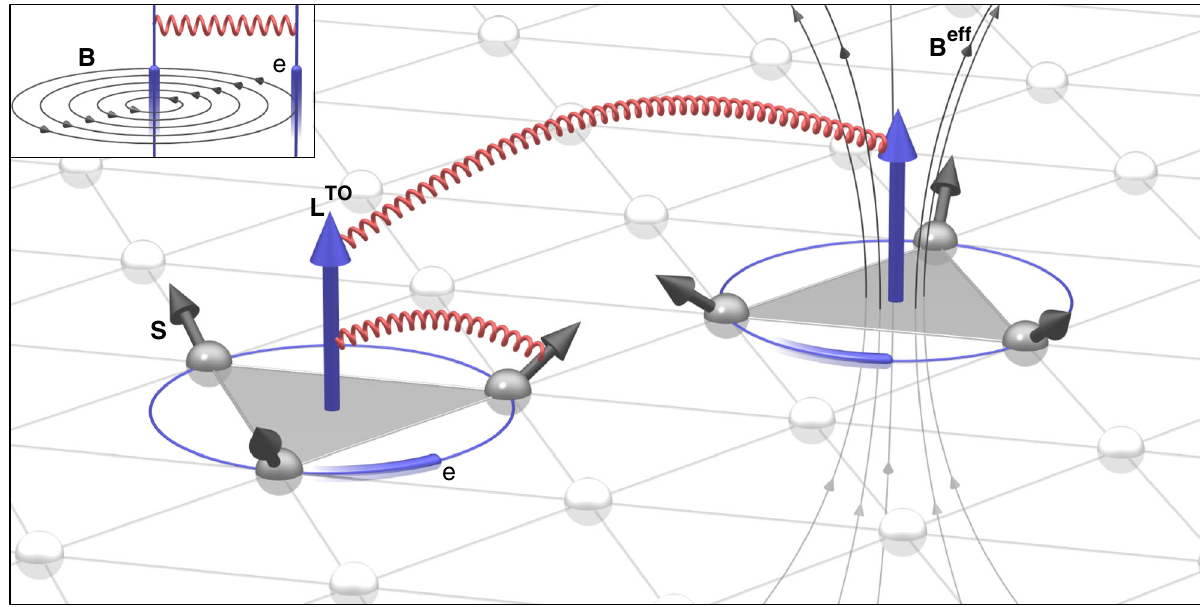
Fig. 1 Topological – chiral interactions. In a magnet exhibiting a non-coplanar spin arrangement (black arrows), the local scalar spin chirality between the triplets of spins can be interpreted as an effective magnetic fi eld B eff which gives rise to a so-called topological orbital moment L TO (TOM, blue arrows) generated by the orbital current of electrons hopping around the triangle. In analogy to Ampère's law shown as inset, the topological orbital currents, generated by different plaquettes of spins, can interact with each other, giving rise to the fi rst type of topological-chiral interactions (cid:1) the rotation-invariant chiral – chiral interaction (CCI). The second type of topological-chiral interactions (cid:1) the spin – chiral interaction (SCI) (cid:1) corresponds to the coupling between TOM and the local spins, mediated by the spin-orbit